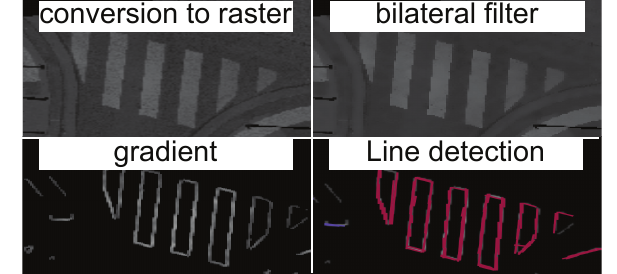
Figure 4: A piece of a point cloud is converted to a